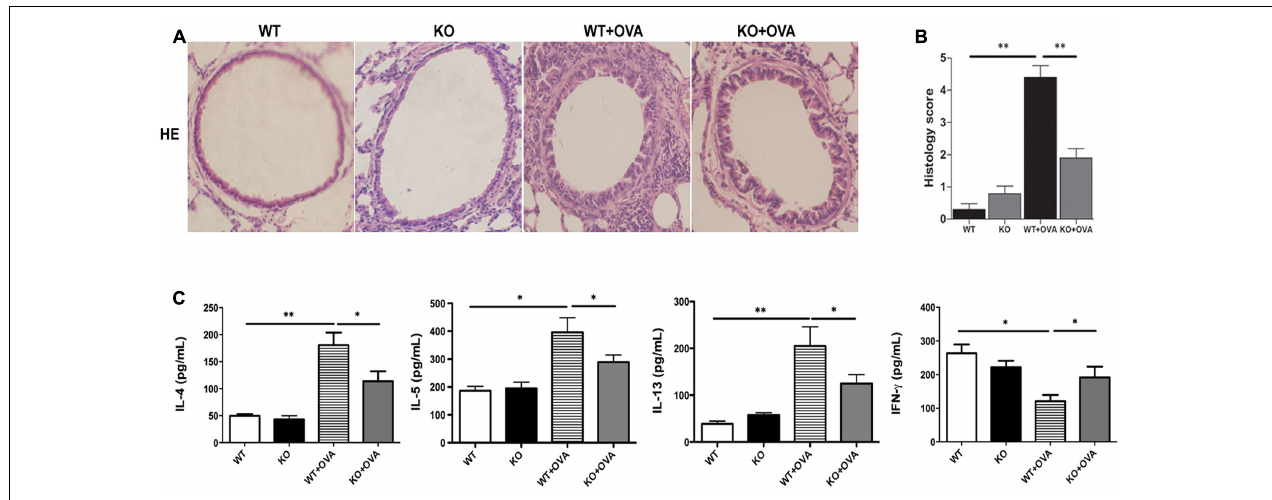
FIGURE 2 | Gene deletion of KCa3.1 reduced established airway inflammation. (A) Representative images of hematoxylin and eosin-stained lung sections from WT, KO, WT + OVA, and KO + OVA groups (original magnification, X30). (B) Quantitative analyses of inflammatory cell infiltration in lung sections. Data were expressed as means ± SEM ( n = 5). ∗∗ p < 0.01, one-way ANOVA followed by the Dunnett’s multiple comparison test compared with WT + OVA mice. (C) Effects of KCa3.1 deficiency on BAL fluid cytokine concentrations in a mouse model of chronic asthma. BAL fluid cytokine concentrations from WT, KO, WT + OVA, and KO + OVA groups. Concentrations of IL-4, IL-5, IL-13, and IFN- γ were analyzed using ELISA. Values were shown as means ± SEM ( n = 6). ∗ p < 0.05, ∗∗ p < 0.01, one-way ANOVA followed by the Dunnett’s multiple comparison test compared with WT + OVA mice. WT, wildtype; KO, knockout.